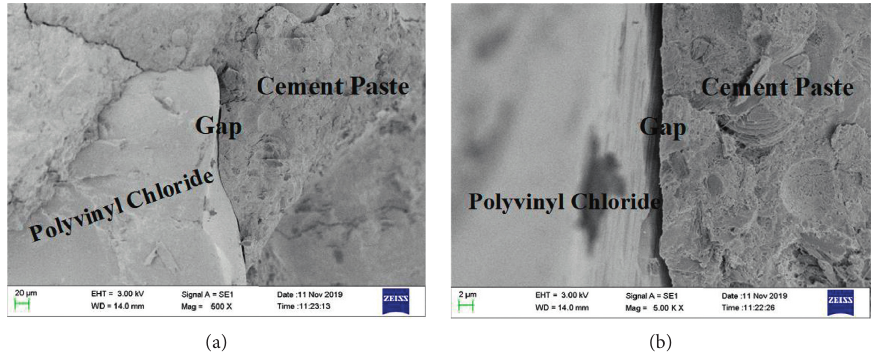
Figure 6: Microstructure of RC-0-0-30 at different magnification. (a) 500x. (b)